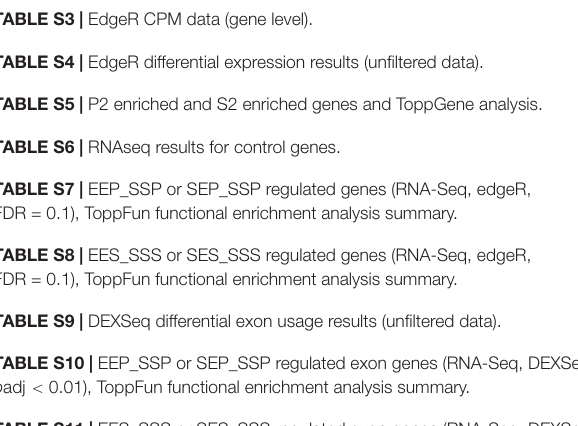
TABLE S2 | RNA-Seq metrics. TABLE S3 | EdgeR CPM data (gene level). TABLE S4 | EdgeR differential expression results (unfiltered data). TABLE S5 | P2 enriched and S2 enriched genes and ToppGene analysis. TABLE S6 | RNAseq results for control genes.